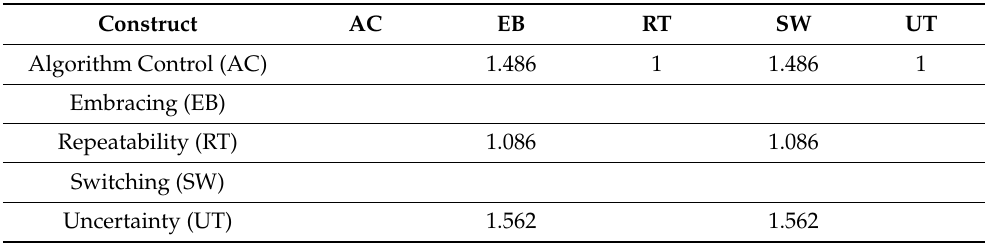
Table A5. Collinearity Statistics